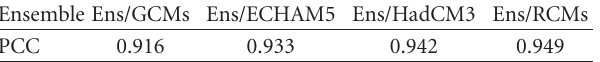
Table 7: Pattern correlation coe ffi cient (PCC) over West Africa from the ensemble of RCMs driven by the same GCMs (Ens/ECHAM5 and Ens/HadCM3) and the ensemble of all RCMs and all GCMs (multi-model ensemble: Ens/RCMs and Ens/GCMs) rainfall with respect to GPCP. Ensembles data are interpolated to GPCP